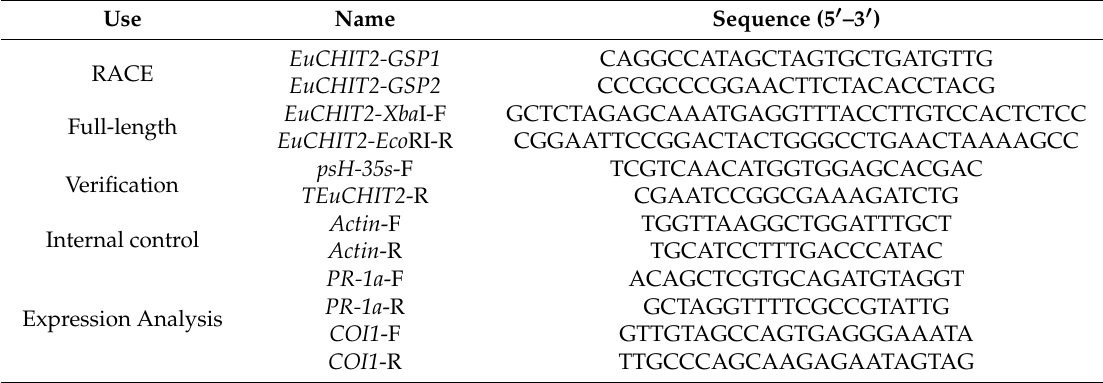
Table 1. Primers used in the full-length cloning and expression analysis of EuCHIT2